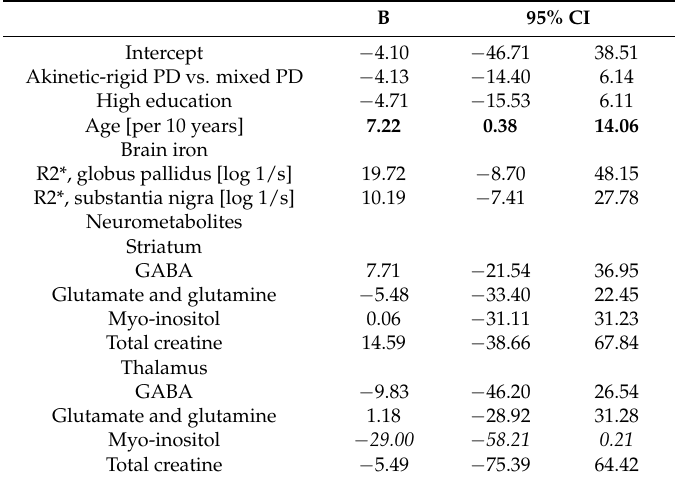
Table 5. Potential predictors of the MDS-UPDRS3 total scores in 35 Parkinson